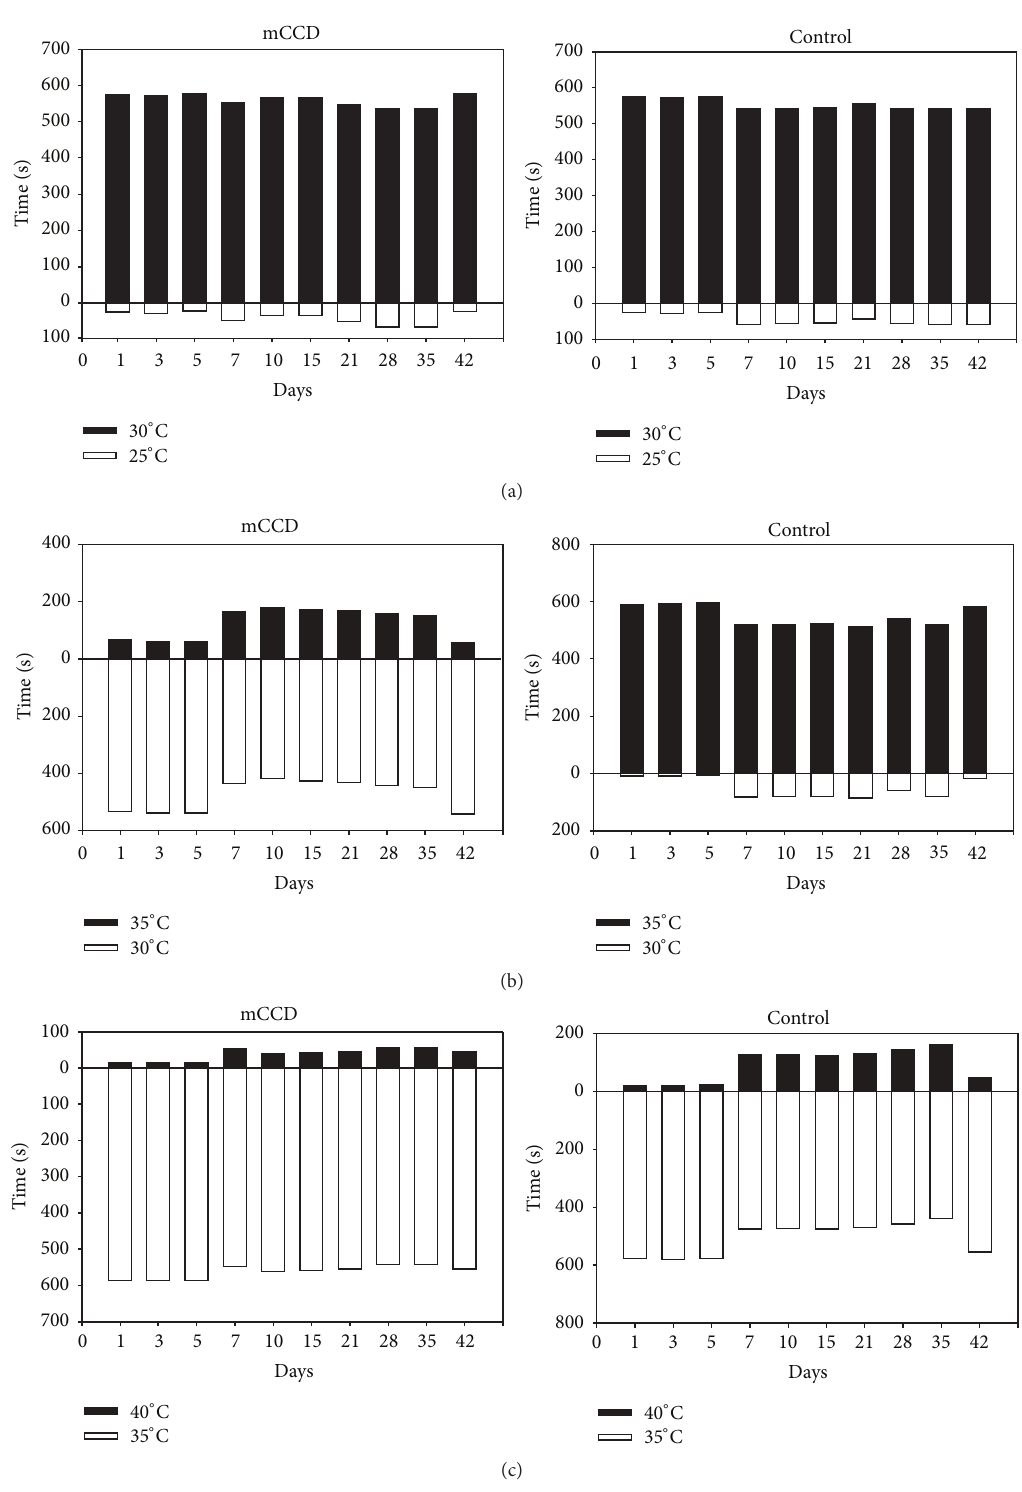
Figure 4: Decreased thermal preference to 30 ∘ C plate during the range of 30 and 35 ∘ C in mCCD rats. (a) Similar thermal preference of 30 ∘ C between control and mCCD rats to the temperature of 25 and 30 ∘ C (two-way ANOVA, 𝑃 < 0.01 ). (b) Decreased thermal preference to 30 ∘ C of thermal preference in mCCD to the temperature of 30 and 35 ∘ C (two-way ANOVA, 𝑃 < 0.01 ). (c) Similar thermal preference of 35 ∘ C between control and mCCD rats to the temperature of 35 and 40 ∘ C (two-way ANOVA, 𝑃 < 0.01